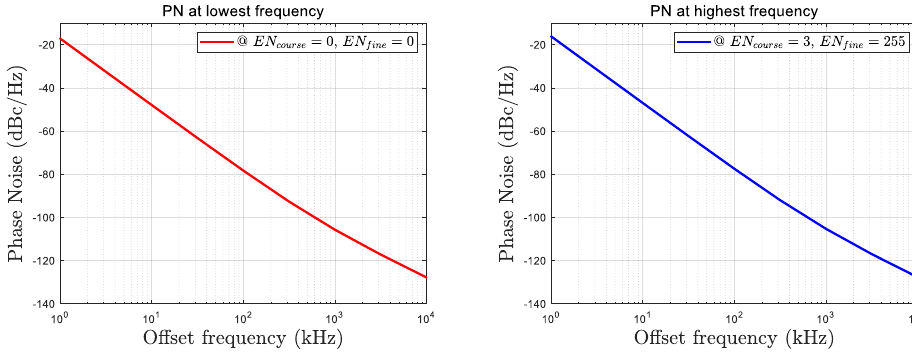
6 of 9 Figure 6. Simulated frequency tuning range ( left ) and 𝐾 𝑉𝐶𝑂 ( right ). The phase noise performance of the proposed VCO is simulated at both the lowest and highest digital code settings. As shown in Figure 7, the phase noise of the VCO is